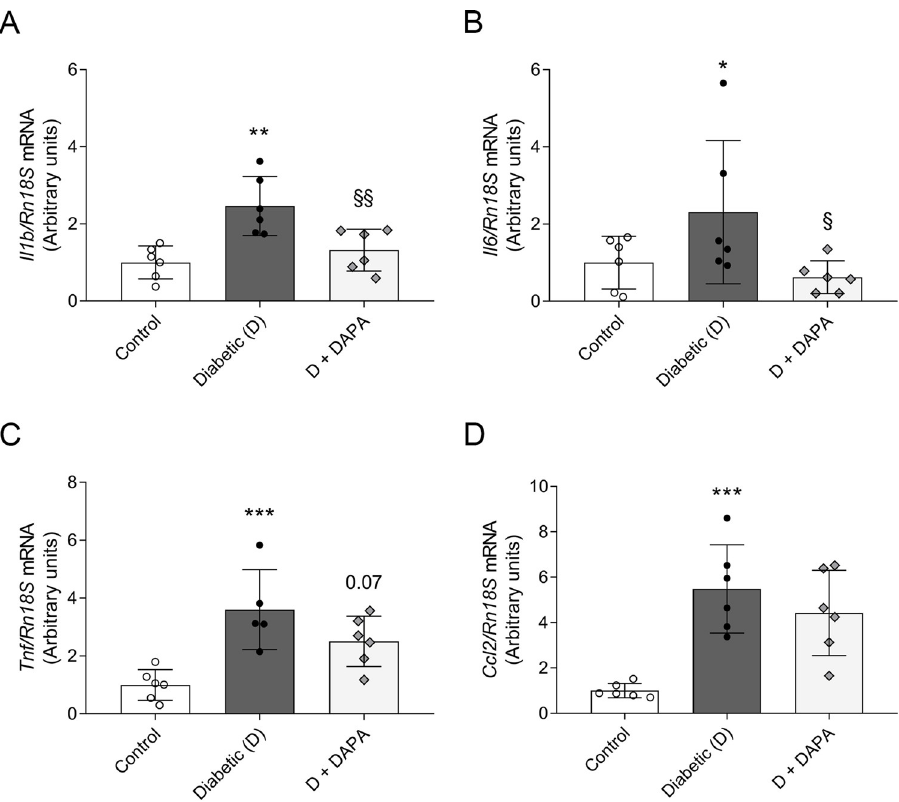
Fig 3. Dapagliflozin mitigates pro-inflammatory response in diabetic heart rats. mRNA expression of (A) interleukin-1 β ( Il1b ), (B) interleukin-6 ( Il6 ), (C) tumor necrosis factor ( Tnf ), and (D) monocyte chemoattractant protein 1 ( Ccl2 ) of control, diabetic and dapagliflozin treated diabetic rats (D+DAPA). mRNA expressions were normalized to Rn18S mRNA expression. Bars indicate means ± SDs and data were analyzed by one-way ANOVA with Holm-Sidak multiple comparisons test (n = 6/group) � p < 0.05 vs . Control, �� p < 0.01 vs . Control, ��� p < 0.001 vs . Control, § p < 0.05 vs . Diabetic, §§ p < 0.01 vs . Diabetic.